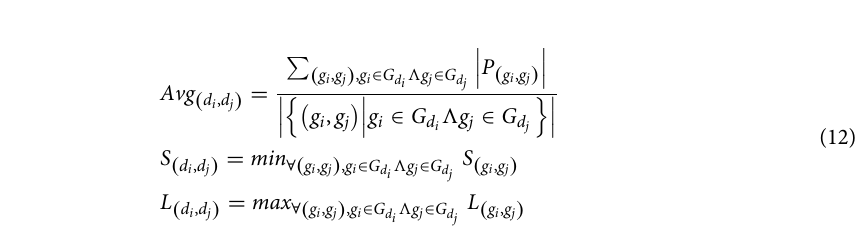
Table 1. Performance estimation of fivefold cross validation and independent test. The bracketed + denotes positive class, the bracketed − denotes negative class and MCC* denotes overall MCC.